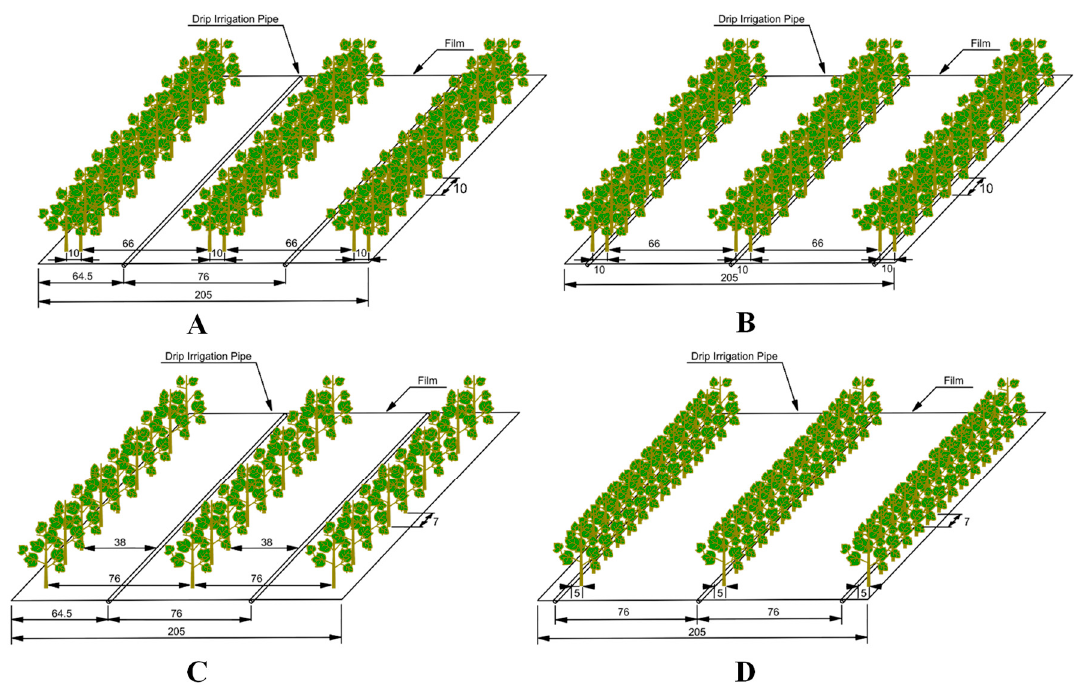
Figure 2. Four different planting mode diagrams: ( A) one film two drips and six rows; ( B ) one film, three drips and six rows; ( C ) one film, two drips and three rows and ( D ) one film, three drips and three rows. Cotton spacing and drip locations are indicated on the map). Table 1. Sampling date and corresponding growing seasons for the ground-measured leaf area in- dex (LAI) and unmanned aerial vehicle (UAV) missions in three experiments.